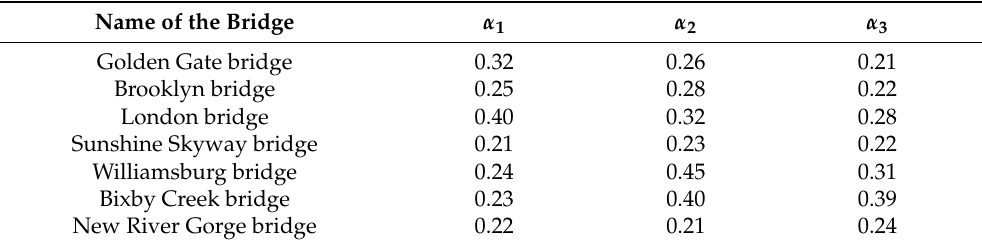
Table 1. The lifetime of a